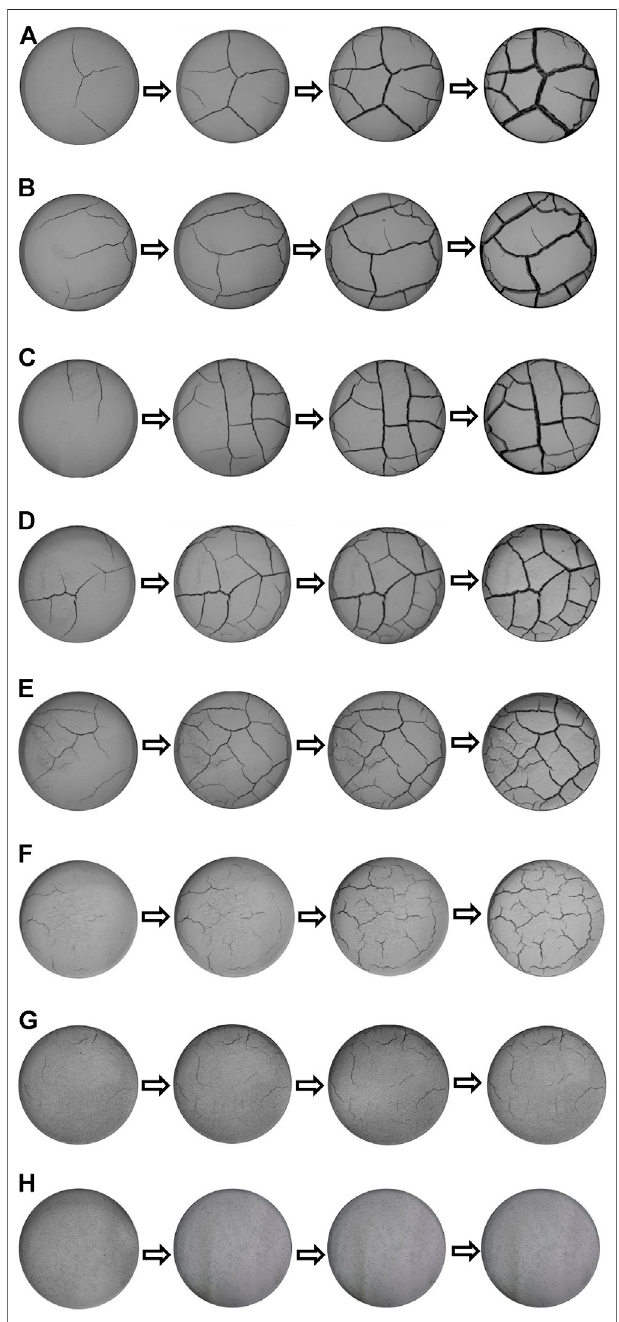
FIGURE 5 | Crack images of different clay content samples at different stages [ (A – H) refers to clay content samples: 100, 90, 80, 70, 60, 50, 40, and